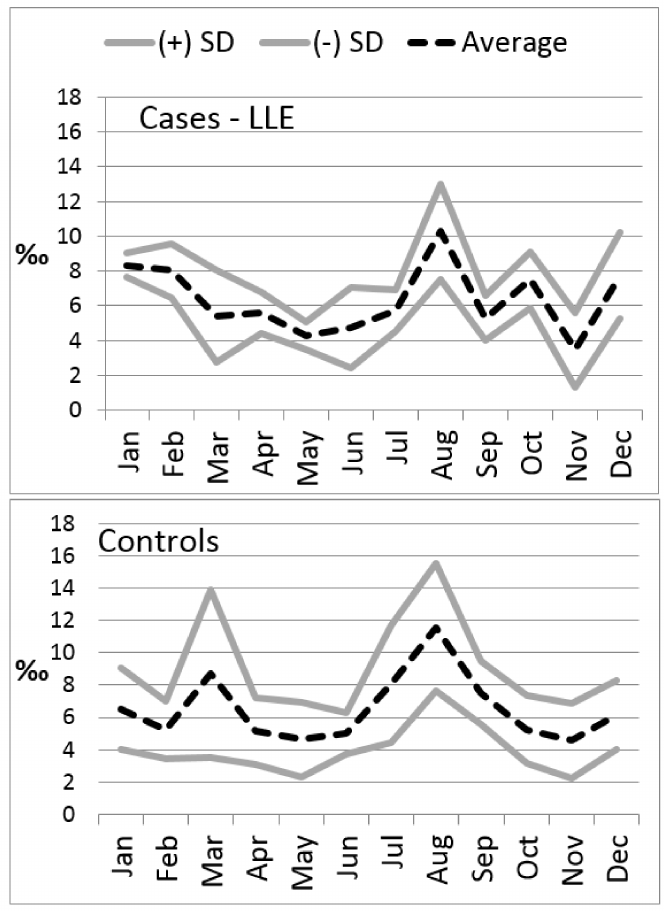
Figure 2. 2015 average monthly death rate and standard deviation with and without an LLE